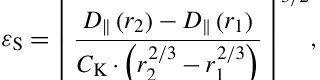
and for l = 4 the condition l(cid:49)y ≤ 20 m is true. In process- r 2 = 20